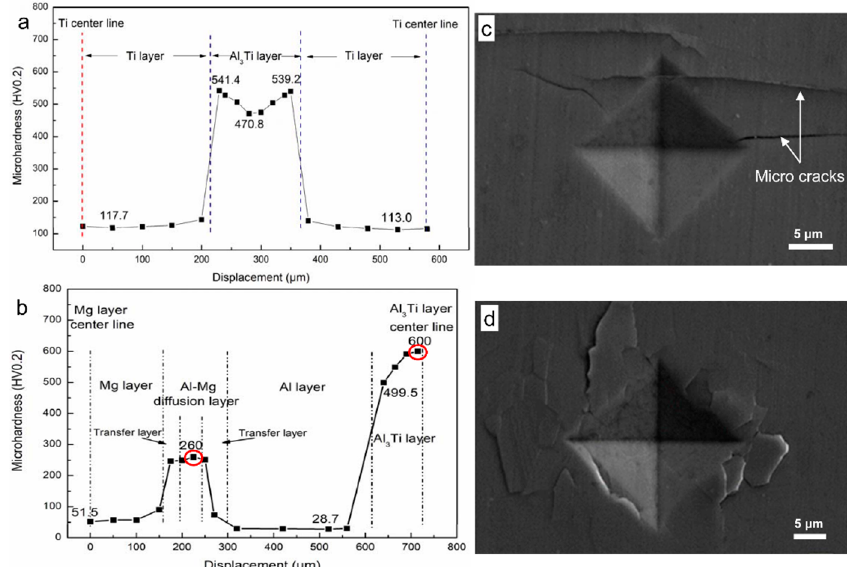
Figure 4. The microhardness distribution and indentations: ( a ) Microhardness distribution at the interface of AlTi-based MIL composite; ( b ) Microhardness distribution at the interface of AlMgTi-based MIL composite; ( c ) Microhardness indentation of Al/Ti diffusion layer; ( d ) Microhardness indentation of Al/Mg diffusion layer.